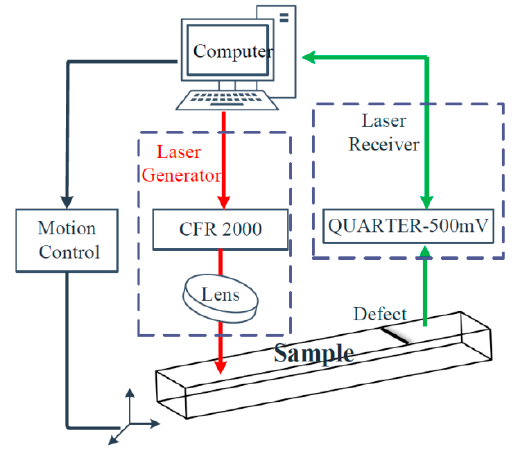
Figure 8. Schematic diagram of the experimental system .